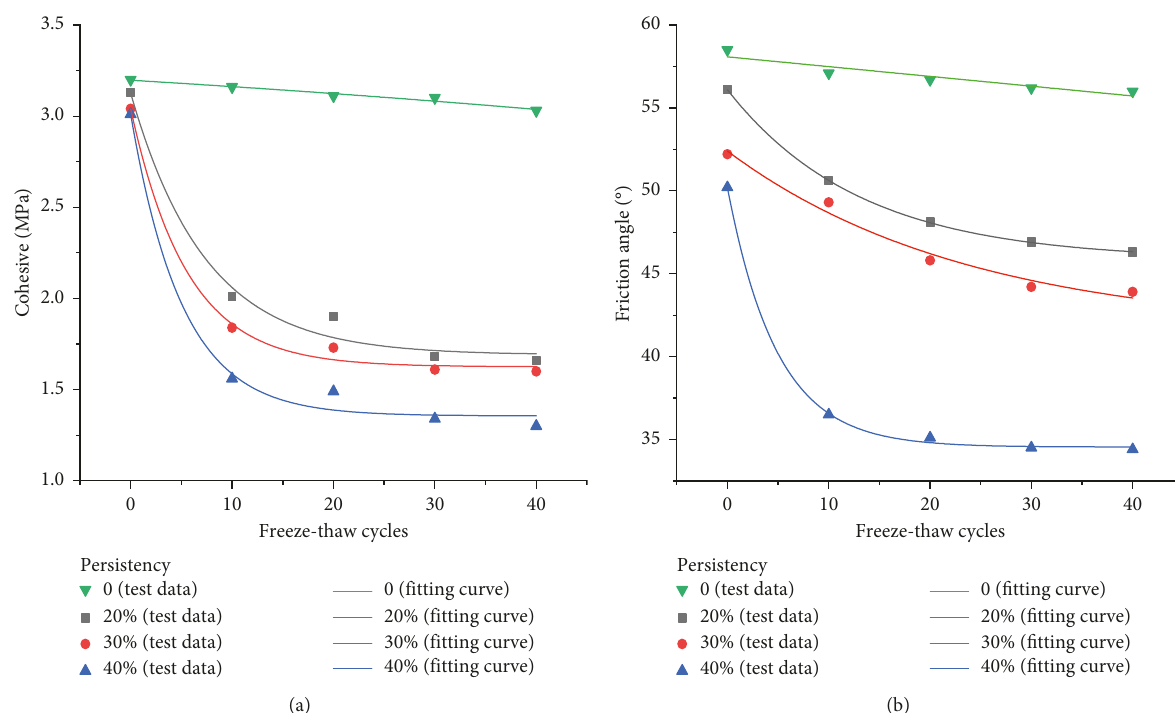
Figure 13: Variation law of shear strength parameters of joint specimens with freezing-thawing cycles: (a) variation law of cohesive and (b) variation law of friction angle.